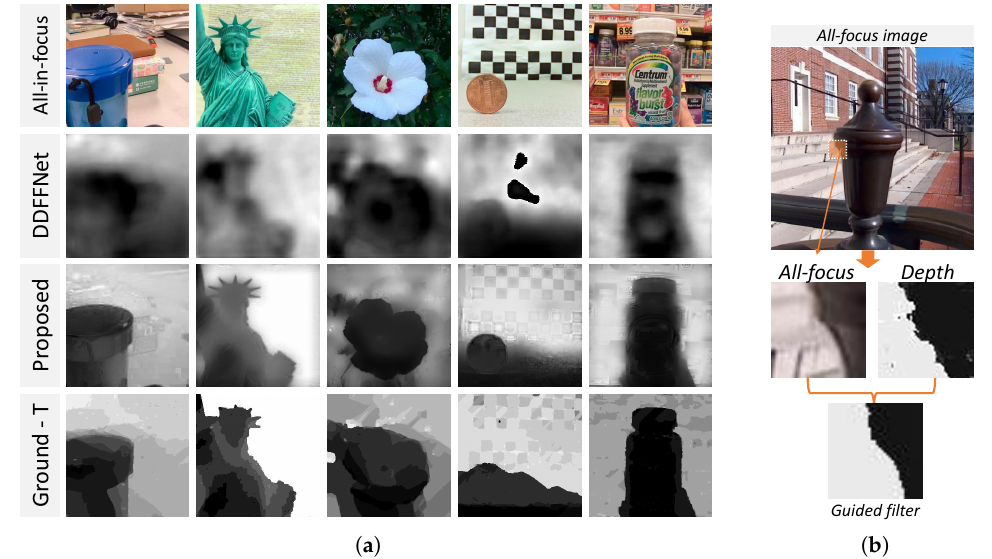
Figure 10. ( a ) Comparison with Deep Depth from Focus (DDFF)Net on LFSD dataset [28]. All samples have 10 frames. First-row: input image, second: results from DDFFNet [22], third: our result, last-row: ground-truth. ( b ) Effect of guided filter [24] on the depth map: it helps keeping